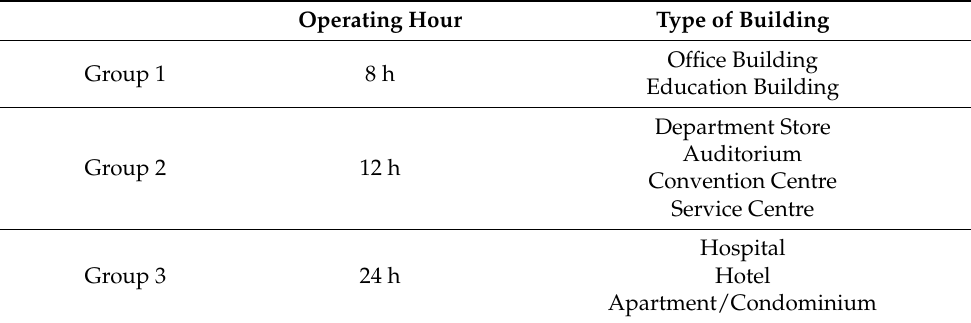
Table 1. Types of building in building energy